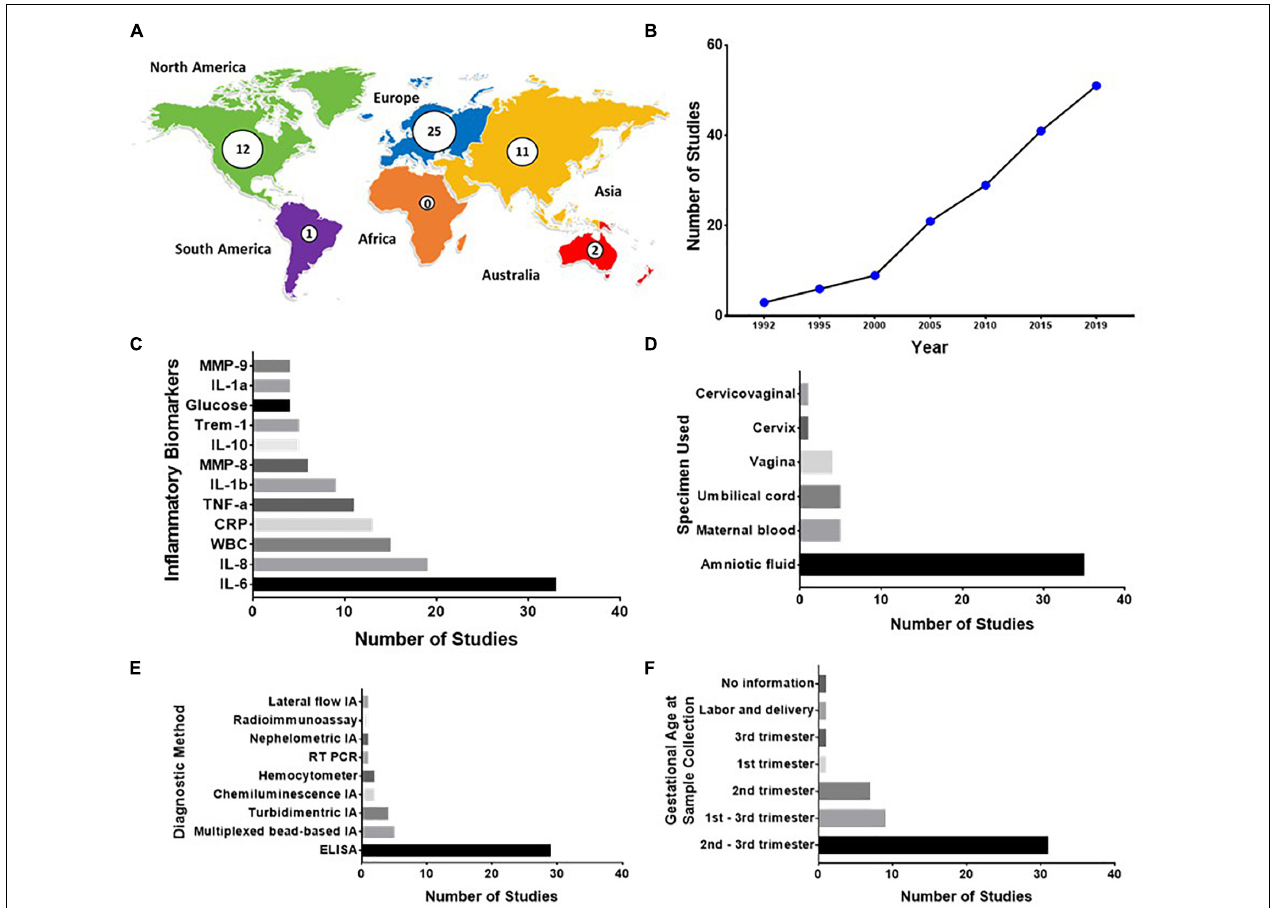
FIGURE 3 | (A–F) Summary of studies on the levels of inflammatory biomarker from pregnant patients with genital Mycoplasma infections. (A) Geographical distribution of published studies on the association between inflammation and genital Mycoplasma infections during pregnancy and preterm birth. (B) Cumulative count of published studies. (C) Top ten most detected inflammatory biomarkers. (D) Samples used for diagnosing genital Mycoplasma infections (E) Diagnostic method used for detecting the inflammatory biomarkers from pregnant patients with genital Mycoplasma infections. (F) Gestational age of patients during the time of sample